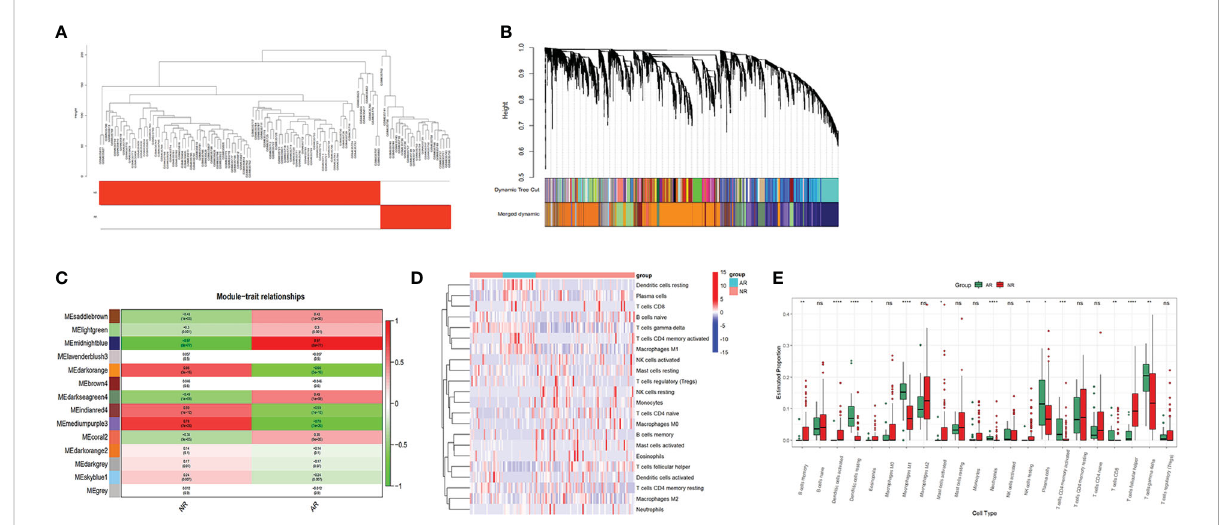
FIGURE 2 WGCNA and immune cell in fi ltration analysis of dataset GSE25902: (A) Clustering analysis of the samples. (B) Gene dendrogram and module colors. (C) Module correlation analysis. (D) Heatmap for immune cells of the AR and NR samples. (E) Comparison of 22 immune cell subtypes between AR and NR groups. *p < 0.05; **p < 0.01; ***p < 0.001; ****p < 0.0001; ns, not signi fi